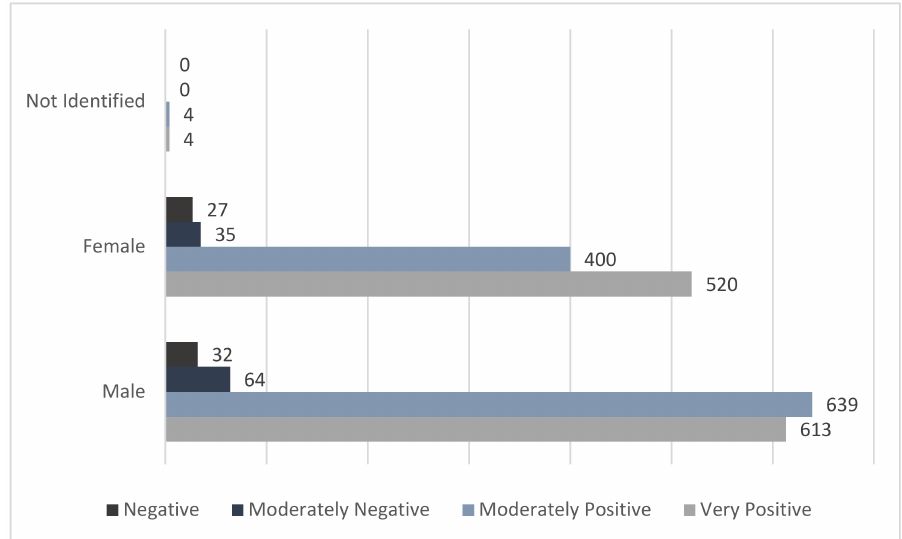
Figure 6. Sentiment analysis results by gender of